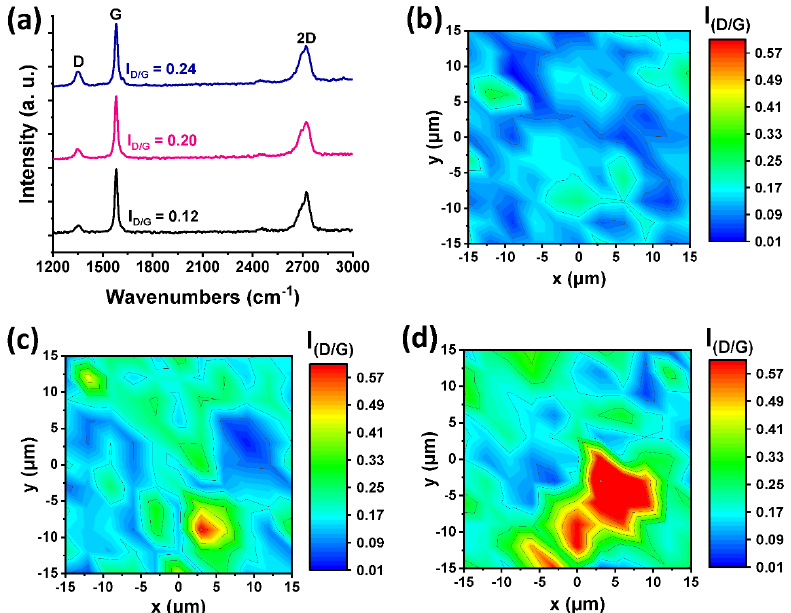
Figure 2. ( a ) Representative (average) Raman spectra (514 nm) of exfoliated graphene (black), [Co]- pyr-graphene (pink) and [Co]-imi-graphene (blue). Spatial Raman spectra (514 nm, 30 × 30 µm ar- eas) of ( b ) exfoliated graphene, ( c ) [Co]-pyr-graphene and ( d ) [Co]-imi-graphene, depicting the I D /I G